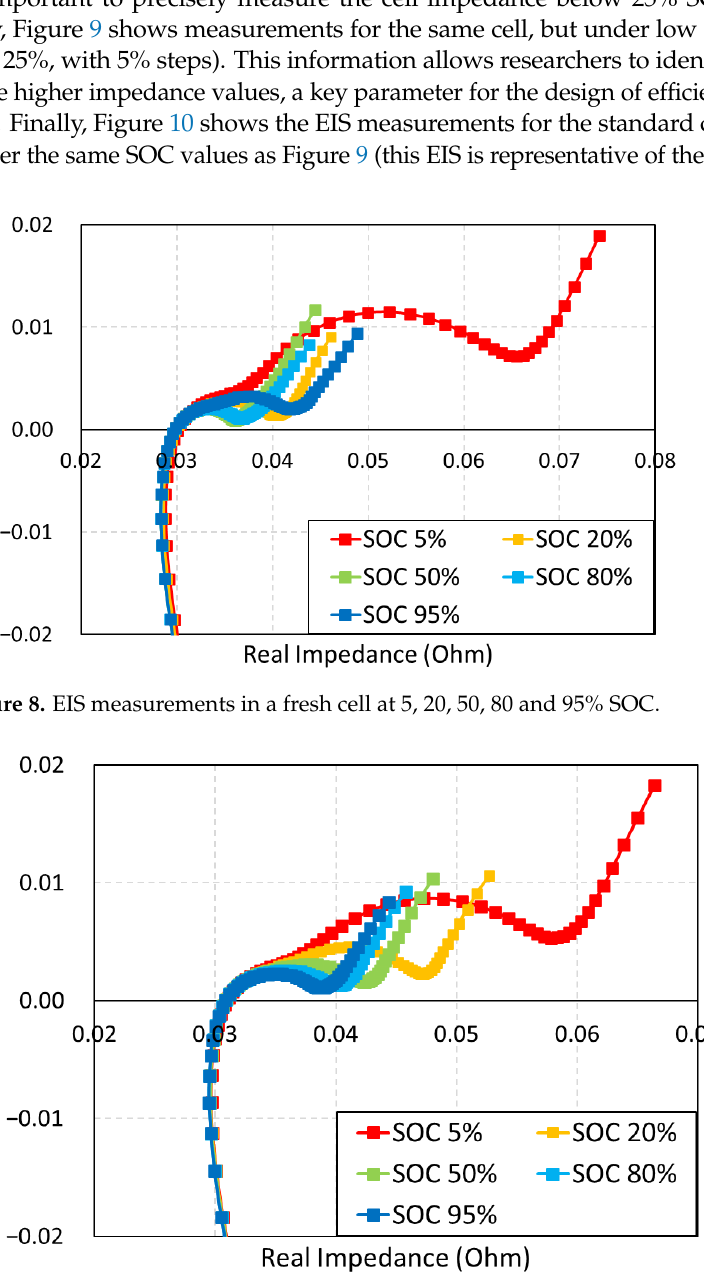
8 of 16 Figure 7. Charging process over time, for a fresh and a high current charge aged cell, under standard (0.5 C) and high current (1 C) charge methods.